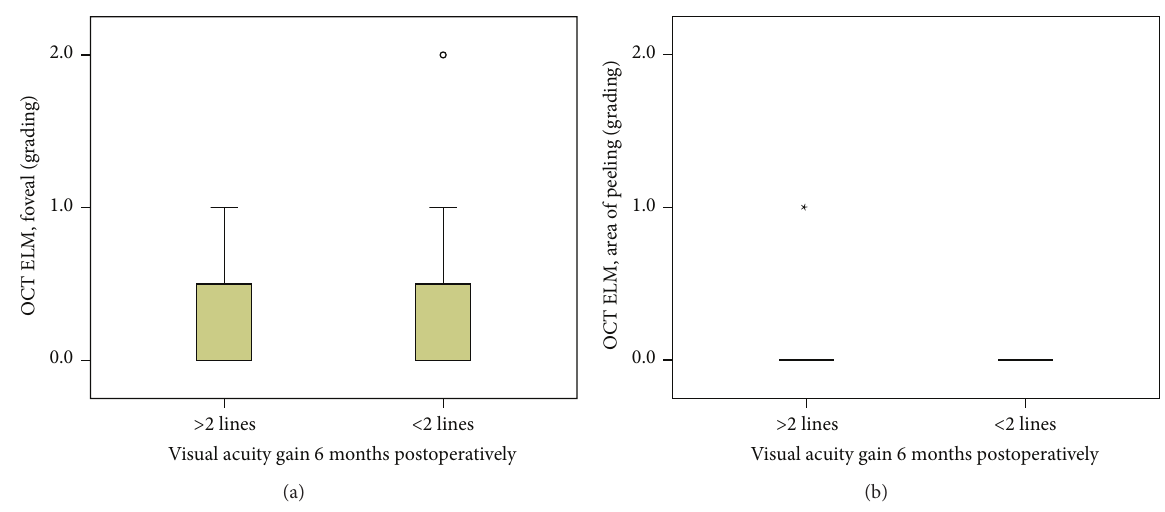
Figure 5: (a) Correlation of preoperative foveal ELM grading and gain of visual acuity 6 months postoperatively. No significant difference between groups ( 𝑝 > 0.05 ). (b)Correlation of preoperative ELMgrading in areas of peeling and gain of visual acuity 6 monthspostoperatively. No significant difference between groups ( 𝑝 > 0.05